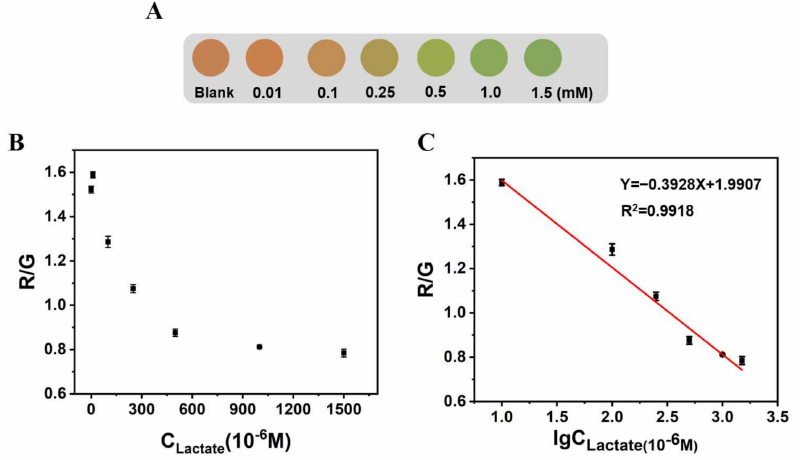
Figure 7. The influence of lactate on the fluorescence color and R/G value of Alg@MFM@QDs-LOx MSs. ( A ) The influence of lactate on the fluorescence of microspheres. ( B ) The R/G value of Alg@MFM@QDs-LOx MSscorrespondingtodifferentlactateconcentrations. ( C )LinearplotoftheR/GvalueofAlg@MFM@QDs-LOx MSs with respect to the logarithm of the lactate